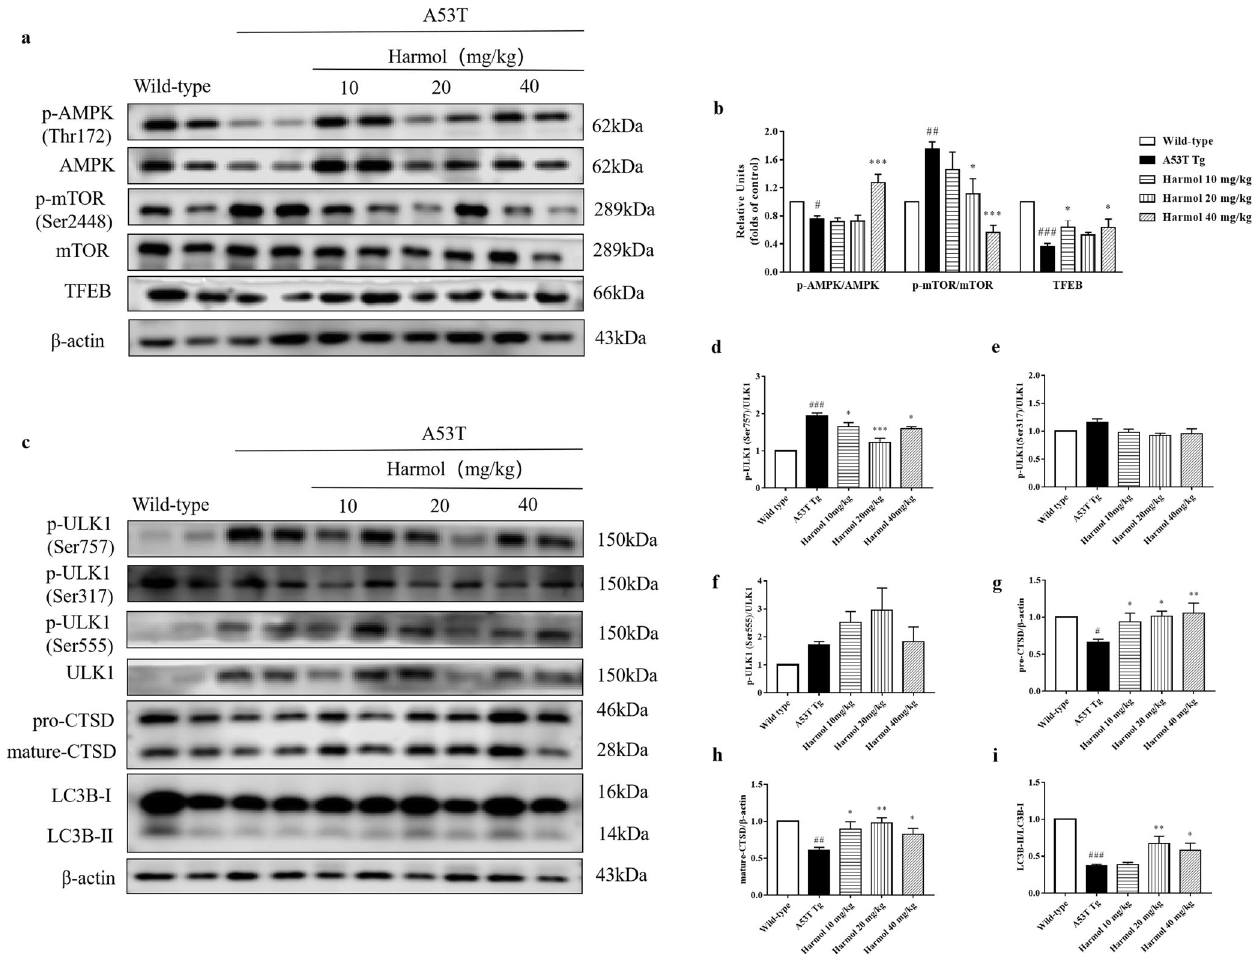
Fig. 7 Harmol activates the AMPK-mTOR-TFEB pathway and enhances autophagy and lysosome biogenesis in A53T α -syn mice. a A53T α - syn mice were treated with 10, 20, and 40 mg/kg harmol for 1 month. Substantia nigra were homogenized and extracted for Western blot analysis. Representative blots of p-AMPK, AMPK, p-mTOR, mTOR, and TFEB are shown. b The levels of p-AMPK/AMPK, and p-mTOR/mTOR, and TFEB were quanti fi ed as the mean ± SEM. # P < 0.05, ## P < 0.01 and ### P < 0.001 vs. the wild-type (saline). * P < 0.05 and *** P < 0.001 vs. the A53T Tg. c A53T α -syn mice were administered with 10, 20, and 40 mg/kg harmol for 1 month. The levels of the LC3B-II/LC3B-I, pro-CTSD, mature- CTSD, p-ULK1 (Ser757), p-ULK1 (Ser317), p-ULK1 (Ser555) and ULK1 in substantia nigra were determined by western blot. Representative